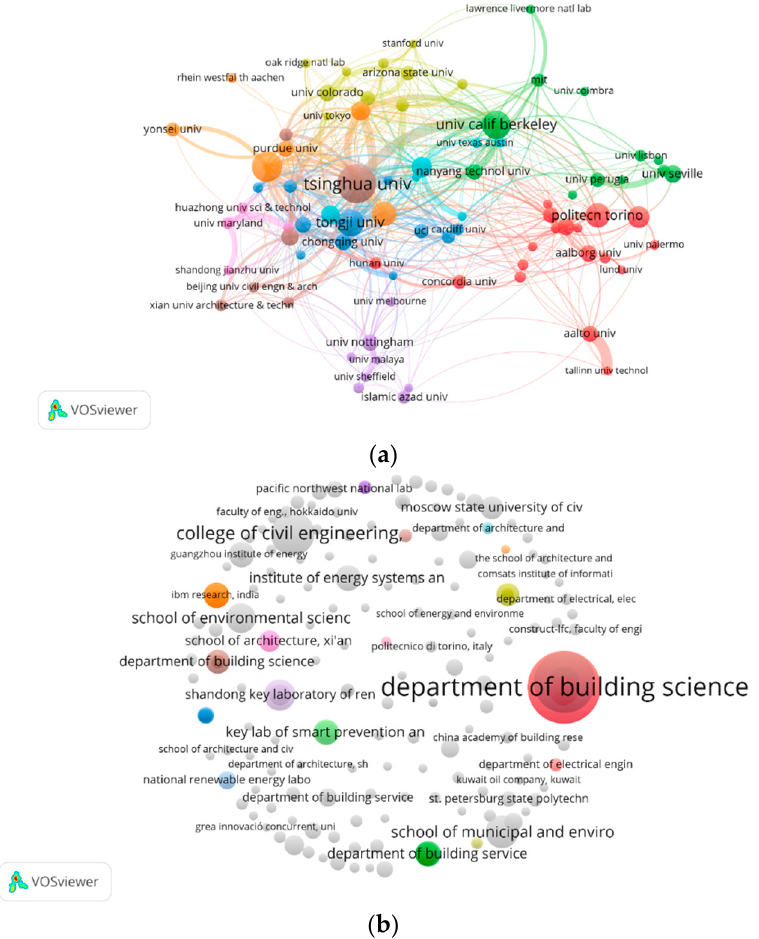
Figure 8. Institutional networks with the highest number of documents in the topic of study during the period January 2013–September 2019: ( a ) Web of Science; ( b ) Scopus.